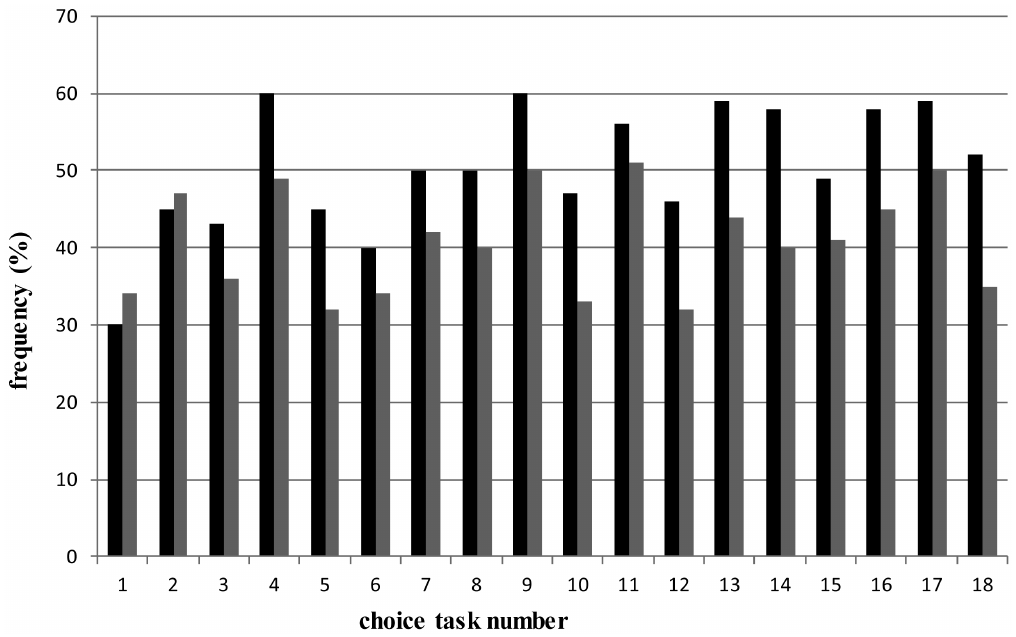
Figure 1. Proportion choosing to opt-out per choice task, stratified by respondents that started with the unforced choices (black) and respondent that were offered the opt-out in the second part of the questionnaire (grey).